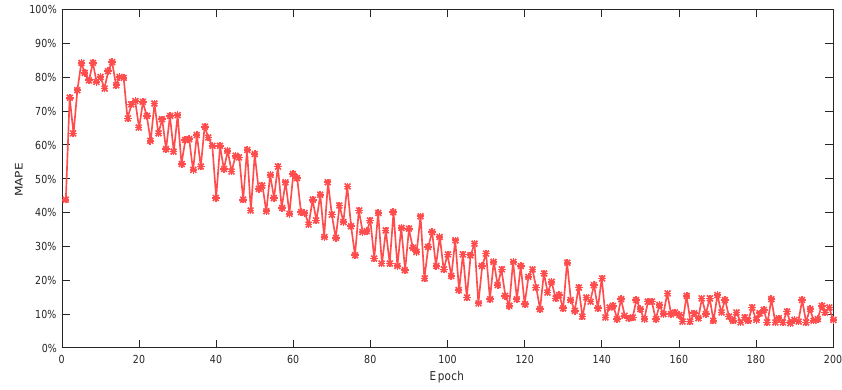
Figure 9. MAPEs during a training period for the Category 2.